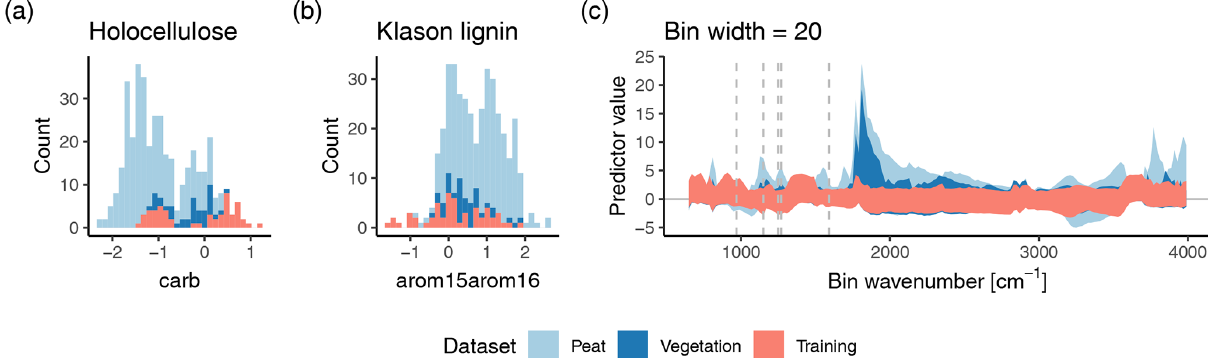
Figure 4. Prediction domain for the original models (a, b) and the improved models using binned spectra with a bin width of 20cm − 1 (c) . The prediction domain is the range of values covered by the predictor variables. The original models use only one predictor variable, and therefore the prediction domain can be shown as spread of the training samples across the x axis (standardized height of the carb and arom15arom16 peak, respectively) of a histogram ( a , b ; blue bars). Extrapolation occurs if other samples (peat, vegetation) exceed this range. Counts are number of samples in the respective datasets. The improved models include bins across the complete spectra (c) . Therefore, the range in standardized predictor variable values ( y axis) covered by the training data for each bin is shown as orange shaded area for the dataset with a bin width of 20cm − 1 , as used by the (nearly) best improved models for holocellulose and Klason lignin. Extrapolation occurs if other samples (blue shaded regions) exceed these areas. Dashed lines indicate the most important variables for the holocellulose and Klason lignin model (compare with Fig.